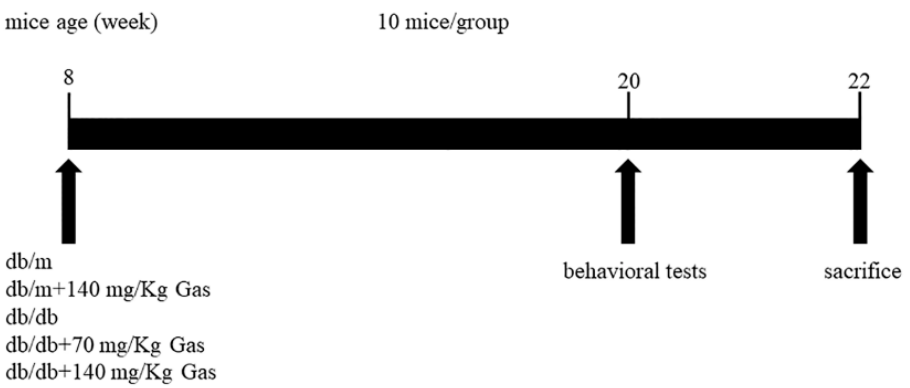
Figure 2. Summary of the experimental design.